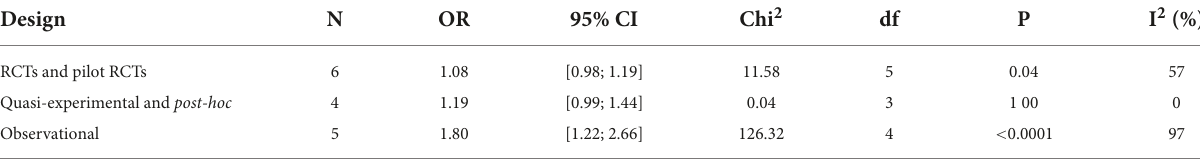
TABLE 1 Odds ratio and heterogeneity by study design. Design